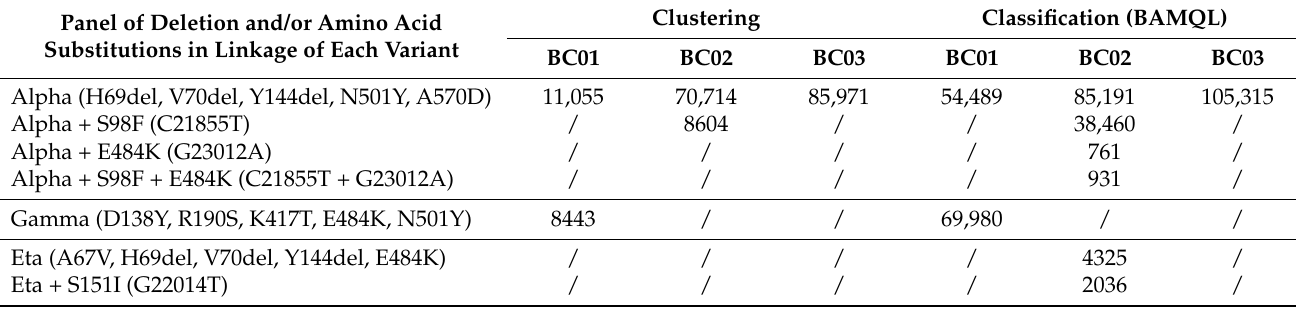
Table 3. Number of reads assigned to each variant/sub-variant by the two bioinformatics analysis approaches. Panel of Deletion and/or Amino Acid Substitutions in Linkage of Each